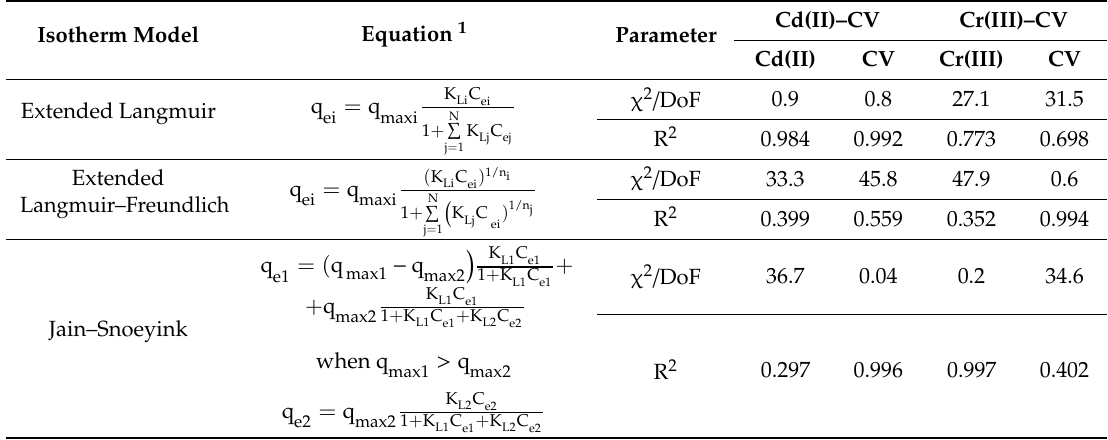
Table 3. Parameter values of the bi-component isotherms for Cr(III)–CV and Cd(II)–CV on FA-H 2 O 2 . Isotherm